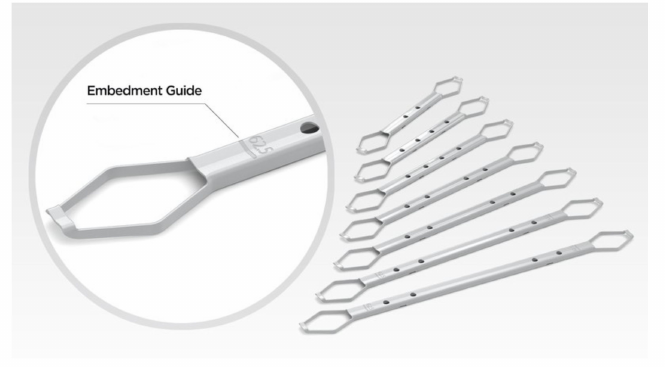
Figure 3. Geometry of the commercial tie tested experimentally from Ancon building products